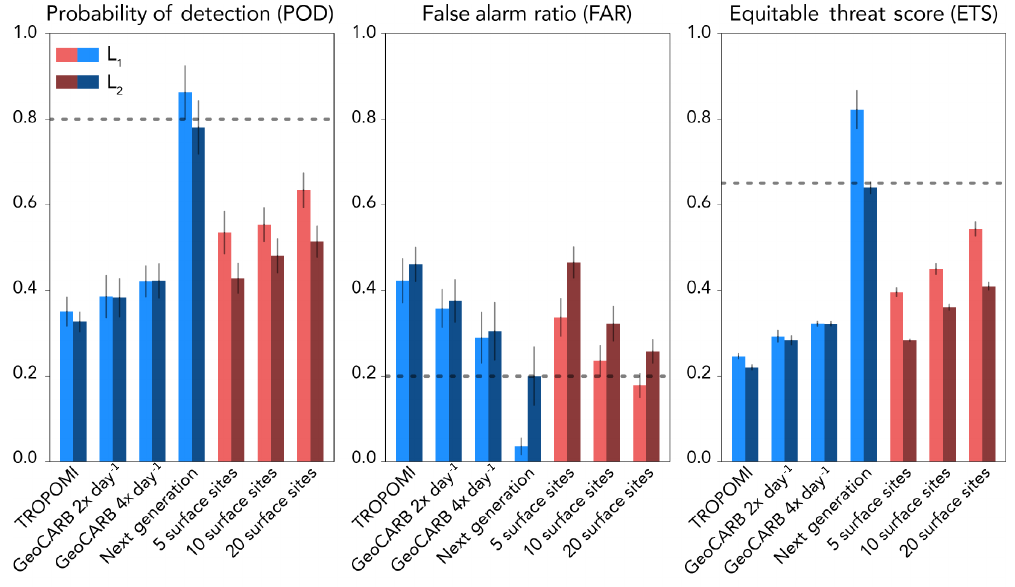
Figure 6. Probability of detection (POD), false alarm ratio (FAR), and equitable threat score (ETS) of high-mode emitters for each satellite and surface observing configuration. Each bar represents the mean of 500 observing system simulation experiments (OSSEs), where 100 pro- duction sites in a 50 × 50km 2 domain were used to construct 500 random realizations of an emission field including different subsets of high-mode emitters. For each observing configuration, the left bar (lighter color) shows results for the inversion with L 1 regularization, and the right bar (darker color) is for the L 2 regularization. The dashed lines represent the POD, FAR, and ETS criteria for successful observing systems. Here, and in following figures, the vertical lines measure the sensitivity to the choice of threshold for diagnosing high-mode emitters in the inversion.